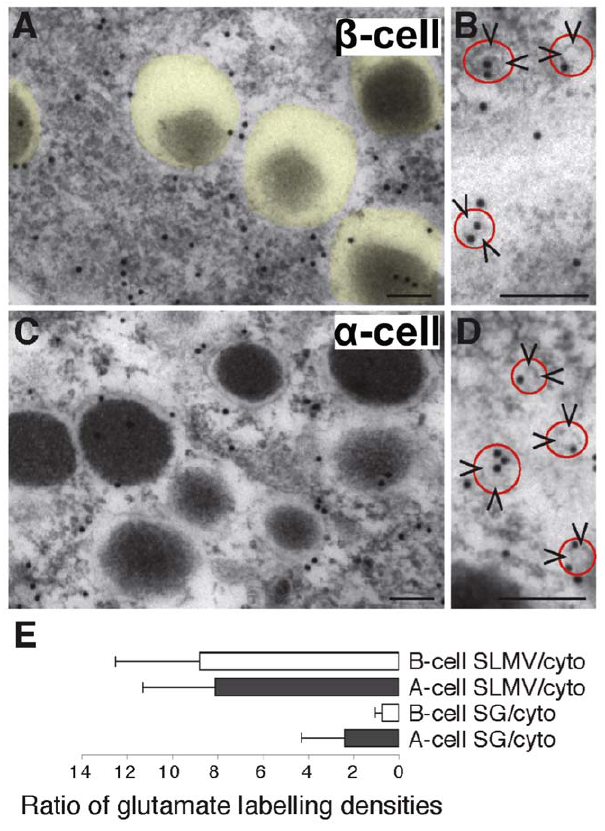
Figure 2. The glutamate concentration in SLMVs is much higher than in secretory granules, and lower in b -cell secretory granules than in a -cell secretory granules. (A) Immunogold particles representing glutamate in b -cell cytoplasm are scarce over secretory granules (transparent yellow). (B) Close up showing glutamate gold particles in b -cell SLMVs (arrowheads, red circle). (C) Immunogold particles representing glutamate in a -cell cytoplasm. (D) Close up showing glutamate gold particles in a -cell SLMVs (arrowheads, red circle). Scale bars A–D, 100 nm. (E) Immunogold quantification shows that the secretory granule (SG)/cytosol (cyto) ratio (mean 6 SD) of net glutamate labelling (background subtracted, see Methods) is signifi- cantly lower in b -cells than in a -cells (p , 0.05, n=5 cells of each